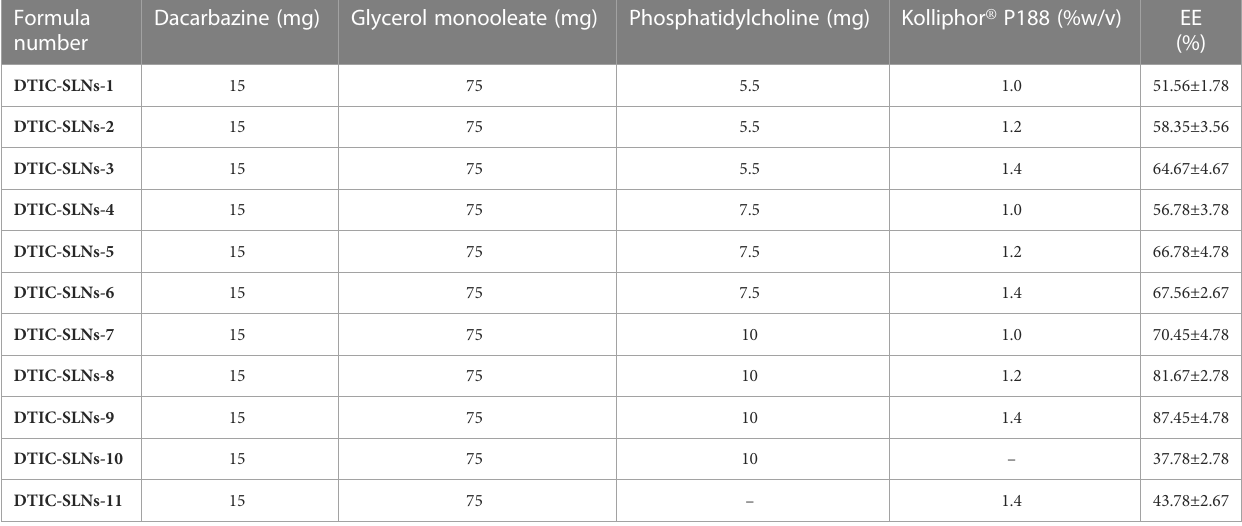
TABLE 1 Components of DTIC-SLNs with resultant encapsulation ef fi ciency of different Dacarbazine solid lipid nanoparticles (means ± S.D, n=3).